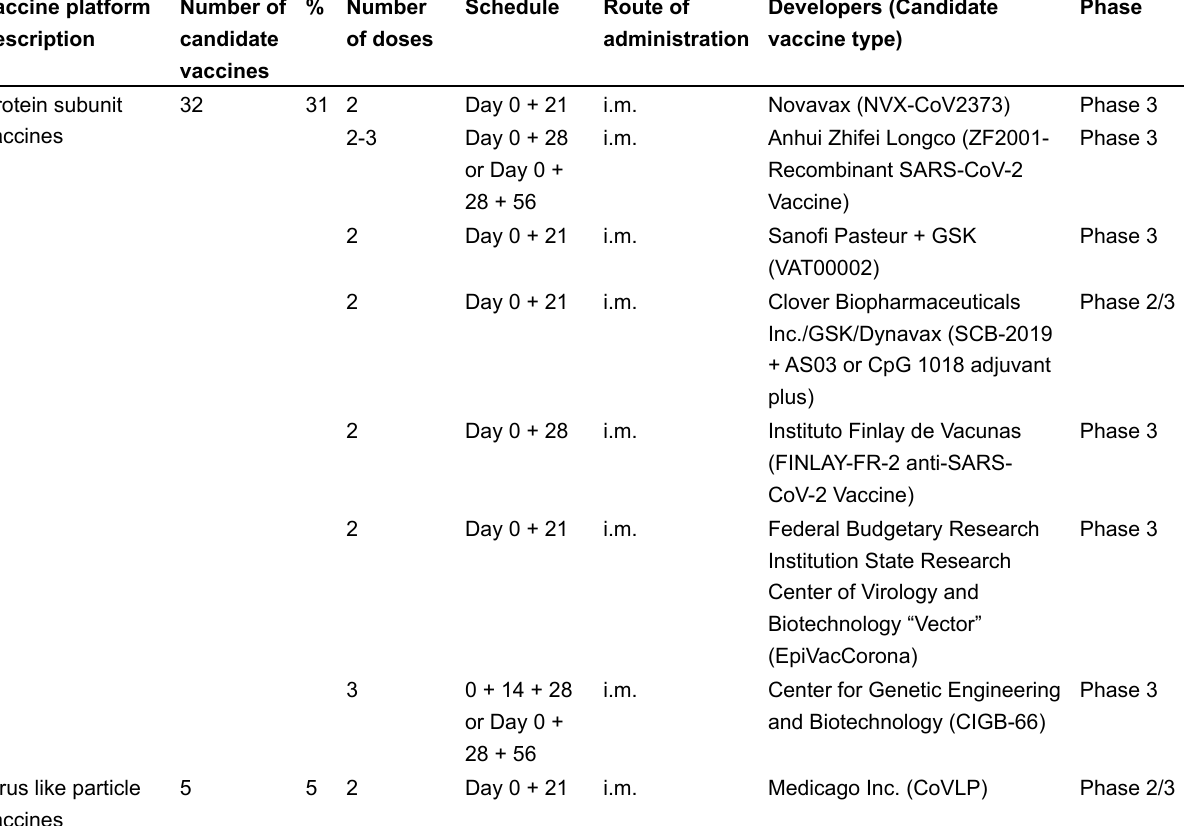
Table 1. Main vaccine types and Phase 3-4 candidates as of June 2021 [50] ( continued ) Vaccine